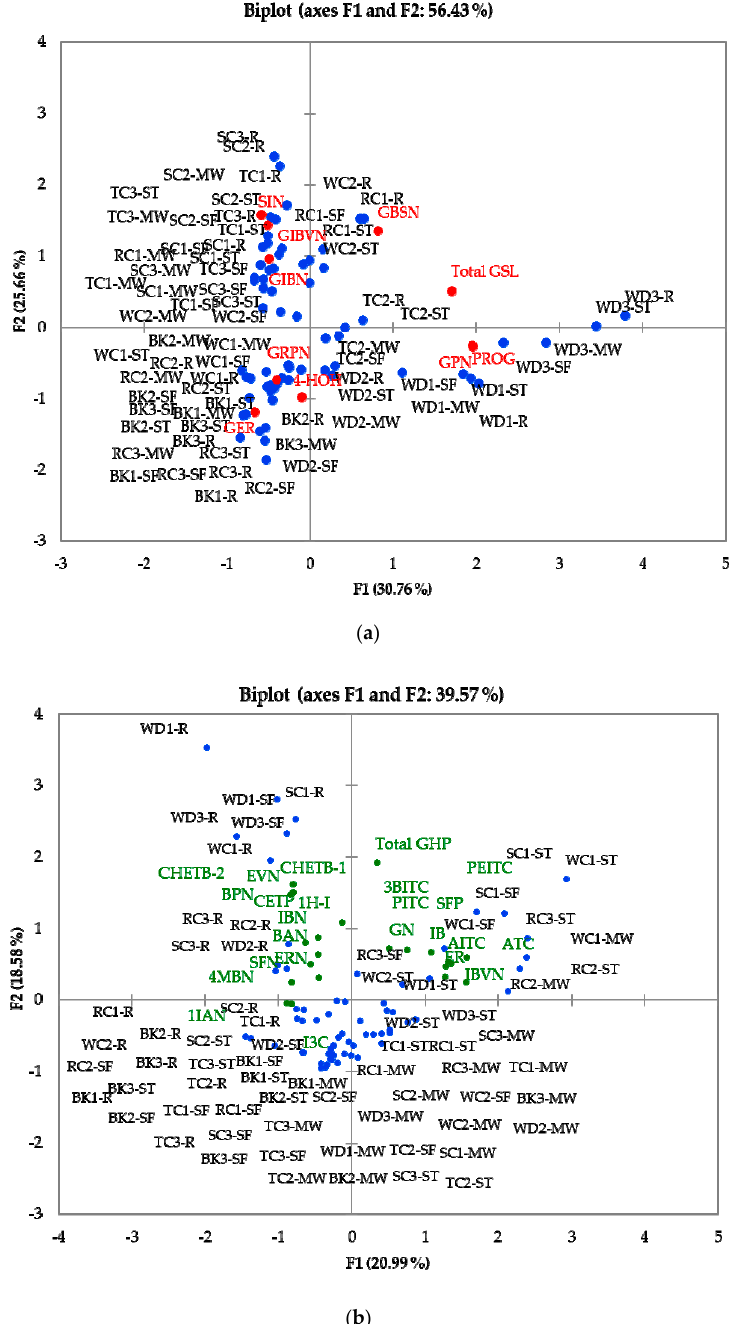
Figure 4. ( a ) PCA plot for tested samples and their relative distributions in relation to GSL concentra- tions. ( b ) PCA plot for tested samples and their relative distributions in relation to GHP concentra- tions. Abbreviations: R = raw, ST = steamed; MW = microwaved; SF = stir-fried; BK1: cavolo nero di toscana o senza palla (BK-CNDTP); BK2: cavolo palmizio (BK-CPNT); BK3: cavolo nero di toscana o senza testa (BK-CNDTT); WD1: wild cabbage 8707 (WD-8707); WD2: wild cabbage 7338 (WD-GRU); WD3: wild cabbage 8714 (WD-8714); TC1: penca mistura (TC-PCM); TC2: penca povoa (TC-CPDP); green (SC-SDG); RC1: red langendijker (RC-RL); RC2: rocco marner (Hybrid) (RC-RM); RC3: red Danish (RC-RD); WC1: early market (WC-FEM); WC2: couve repolho (WC-CRB). Red coloured compounds = GSLs; Green coloured compounds = GHPs; Blue dots = Samples. For full names of compounds, see Tables 1 and